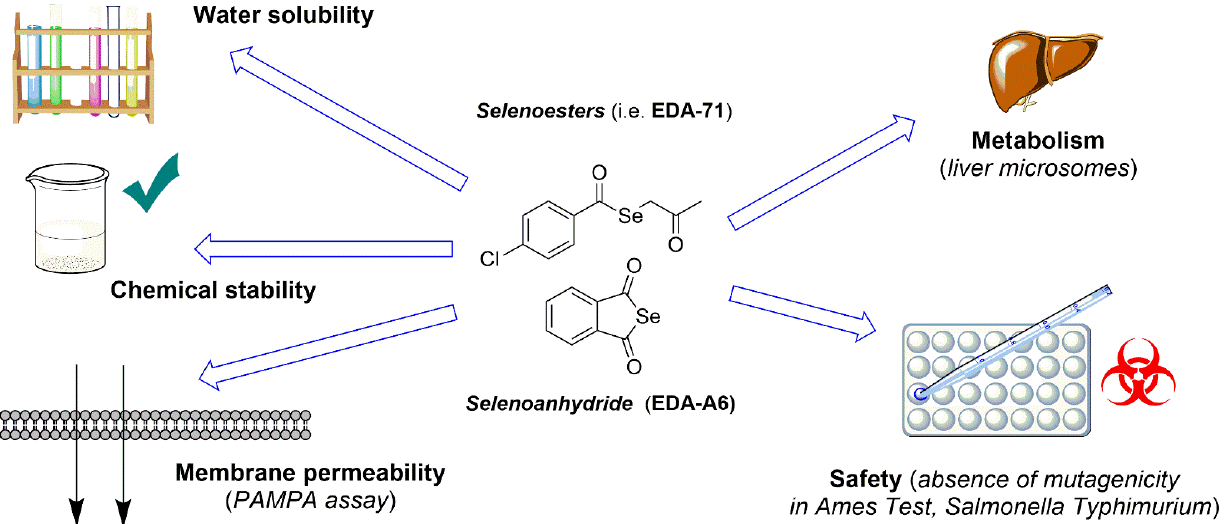
Figure 2. ADME and safety experiments carried out in this work for specific selenocompounds.